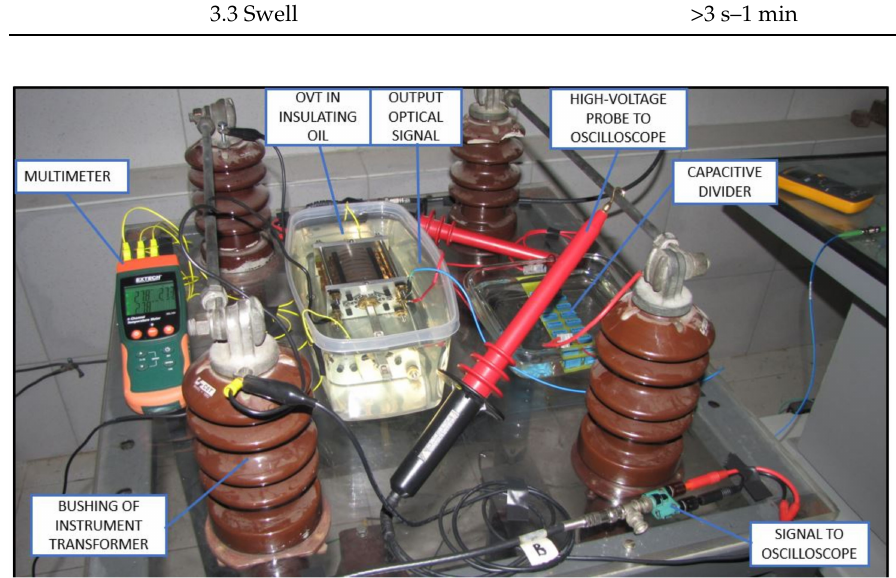
Figure 9. Experiment setup in high voltage room (adapted from [7] with permission). The capacitive divider on the right side of the bench is used when testing the OVT for the higher voltage values found on 13.8 kV distribution